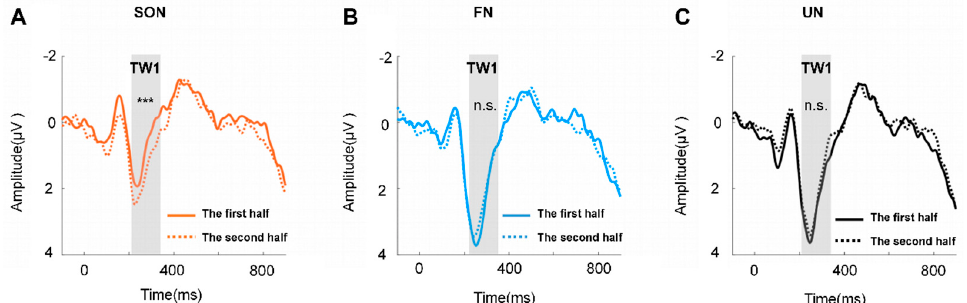
Figure 4. The grand average waveform across the channel of TW1 (Fz, FC1, FC2). ( A ) The grand average waveform of SON between the two halves of trials. ( B ) The grand average waveform of FN between the two halves of trials. ( C ) The grand average waveform of UN between the two halves of trials. *** = p < 0.001, n.s. = p > 0.05.